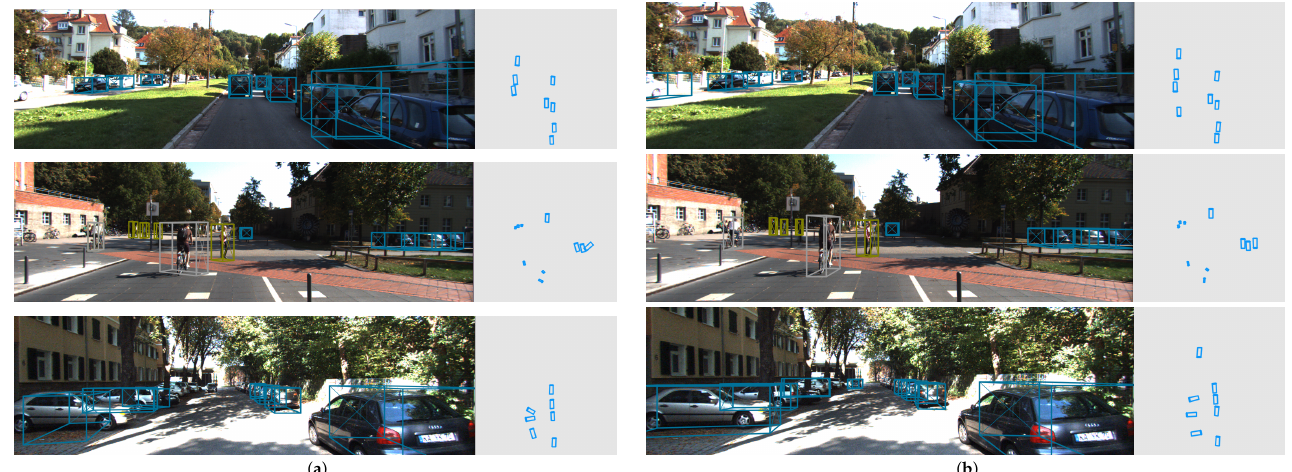
Figure 10. Qualitative comparisons of the detection performance in 3D and BEV on the KITTI test set. ( a ) Baseline work (CenterNet). ( b ) The proposed method (Keypoint3D). Cars, pedestrians, and cyclists are represented by pale blue, brown, and gray boxes, respectively. The heading direction is represented with a cross